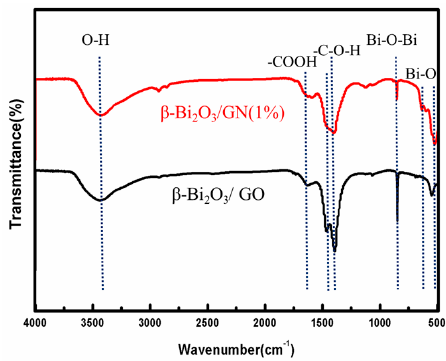
Figure 2. Fourier transform infrared (FTIR) spectra of β -Bi 2 O 3 /GN (1%) and β -Bi 2 O 3 /GO.